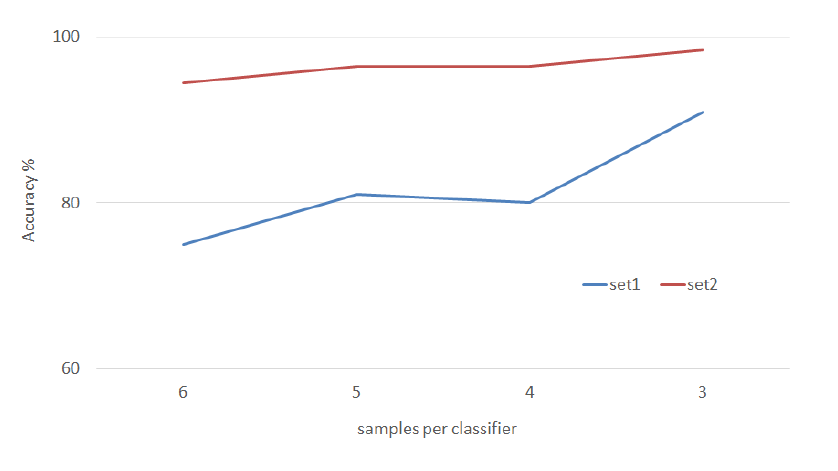
Figure 13. Obtained recognition rates with varying numbers of samples per sub-SVM classifier.